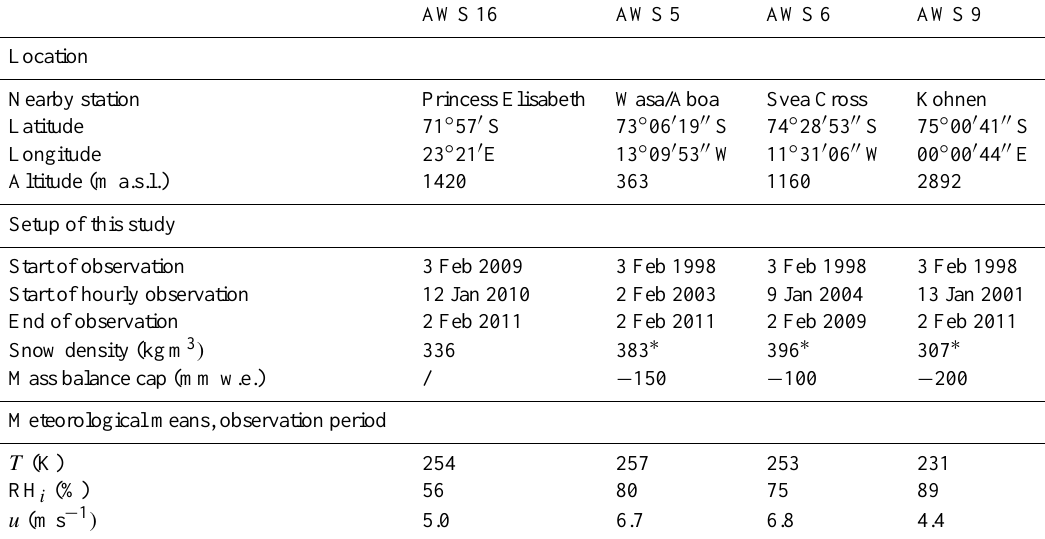
Table 1. AWS characteristics. ∗ : values from Van den Broeke et al. (2004a) for 1998–2001. The snow density at AWS 16 was retrieved from the first 85cm of an ice core drilled in February 2009 near the station. Start and end of observation mark the first respectively last entry used in this study; all stations except AWS 6 are still operational. Also, note that AWS 16 has no lower bound for the mass balance since no mast extension has been conducted yet.